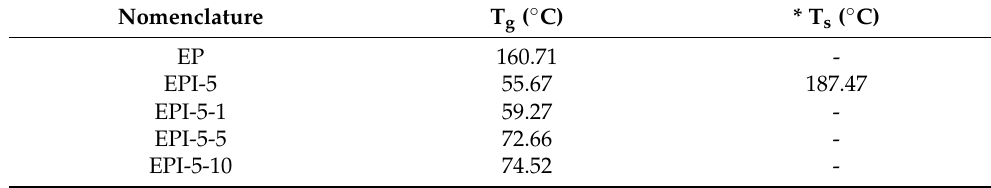
Figure 1. Curing temperatures of epoxy/polyimide blends analyzed as a function of polyimide content in N 2 gas atmosphere. Table 1. DSC parameters of postcured epoxy/polyimide blends analyzed in N 2 gas